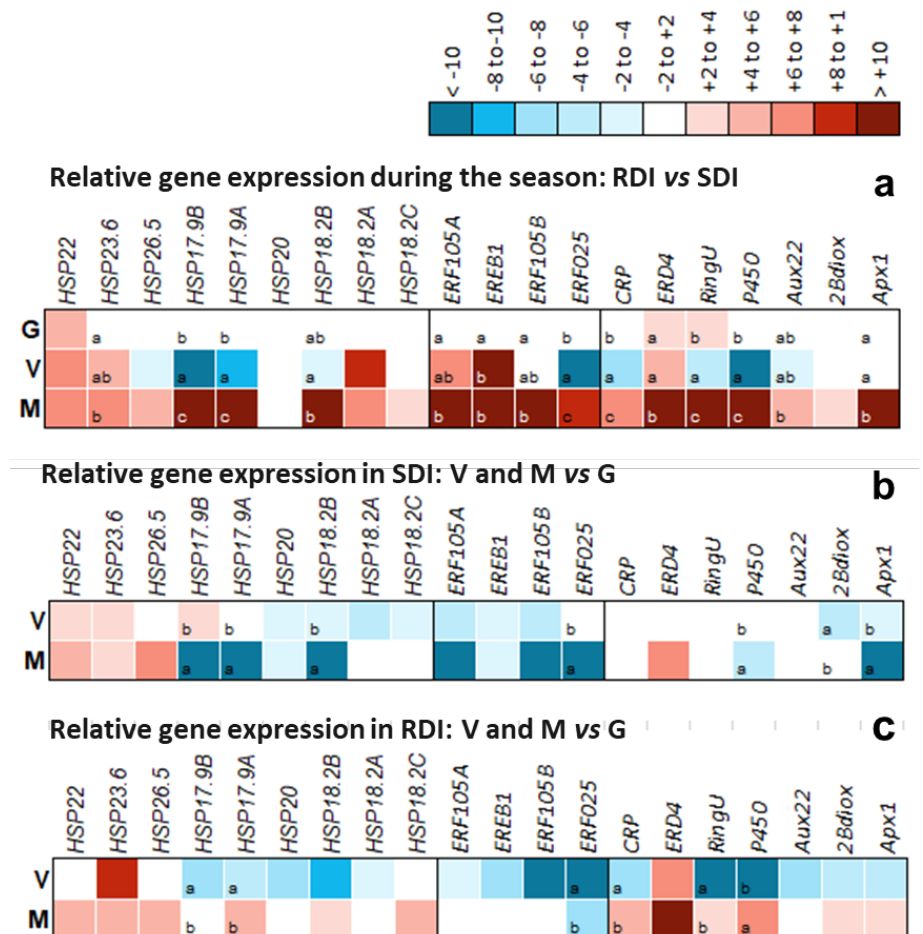
Figure 6. Relative gene expression ratios obtained by RT-qPCR of the DEGs of interest ( HSP22 ; HSP23.6 ; HSP17.9B ; HSP17.9A ; HSP20 ; HSP18.2B ; HSP18.2A ; HSP18.2C ; ERF105A ; EREB1 ; ERF105B ; ERF025-like ; CRP ; ERD4 ; RINGU ; P450 ; AUX22 ; 2ßDIOX1 ; APX1 ) in ( a ) regulated deficit irrigation (RDI) when comparing to sustained deficit irrigation (SDI; as control) in pea size (G), véraison (V), and full maturation (M); ( b ) in SDI, when comparing G (as control) with V and M; ( c ) in RDI, when comparing G (as control) with V and M. RT-qPCR values were standardized with the CT values of three reference genes; Actin 2; TIF, and TIF-GTP. Different letters indicate significant differences ( p -value < 0.05) in the expression of each DEG between the development stages. Values within |log 2 (gene expression level)| < 2 are not significantly different from the respective controls (RDI vs. SDI in ( a ); G vs. V and M in ( b , c